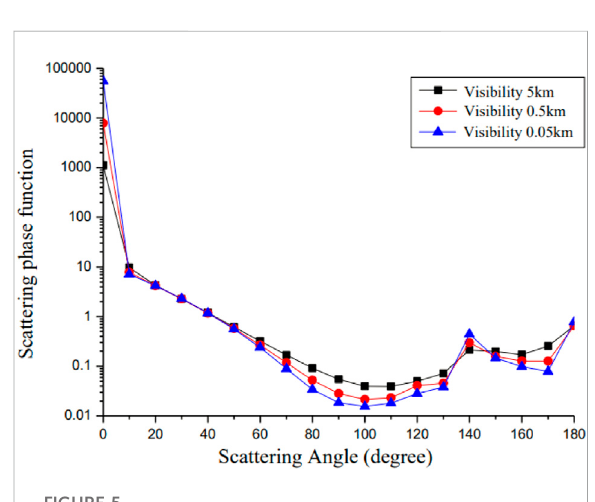
FIGURE 5 Scattering phase function and scattering angle